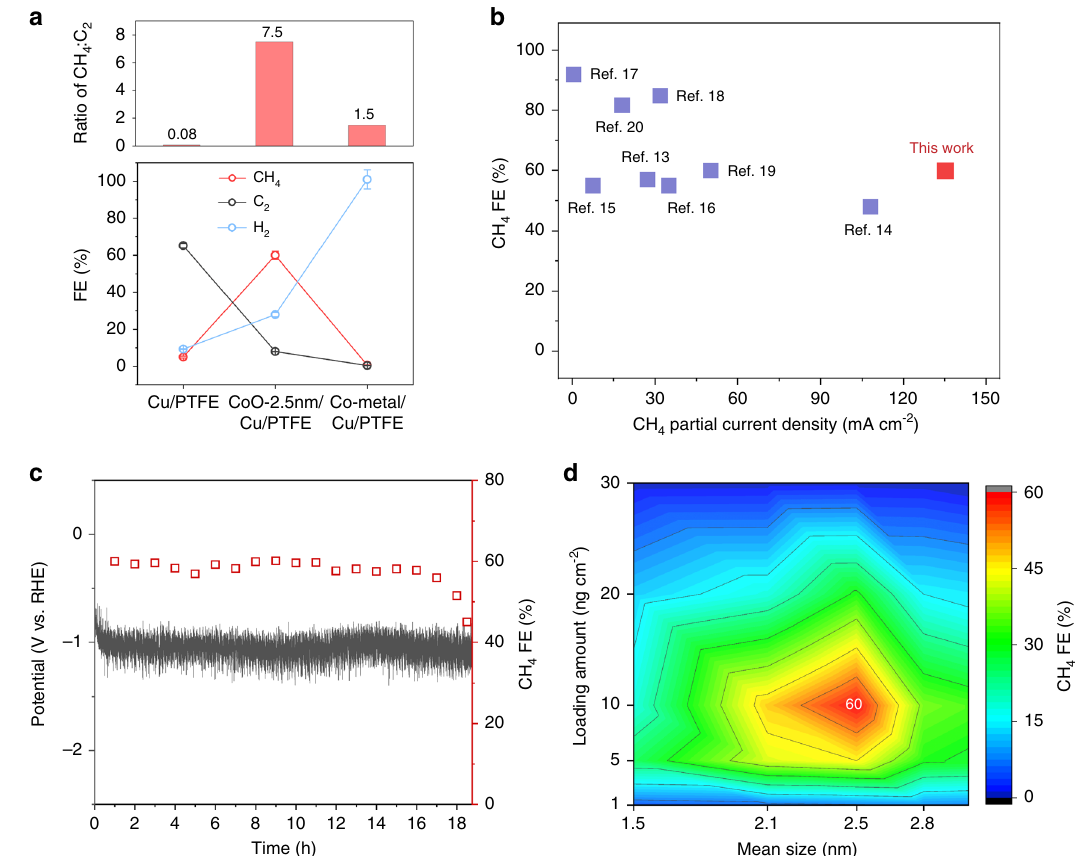
Fig. 3 Electrocatalytic performance of electrocatalysts. a Product distribution of CoO/Cu/PTFE, Co metal/Cu/PTFE and bare Cu/PTFE at the − 1.1 V vs. RHE. Red circle for methane, blue circle for hydrogen and grey circle for C 2 products. b CO 2 -to-CH 4 performance of CoO/Cu/PTFE in comparison with recent reports 13 – 20 . Blue square for the results in literature. c Stability test of CO 2 methanation during 18.5 h of electrolysis under the current density of 225 mA cm − 2 . Red square for methane FE and grey line for potential curve. d CH 4 FEs of ligand-stabilized CoO clusters with different sizes and